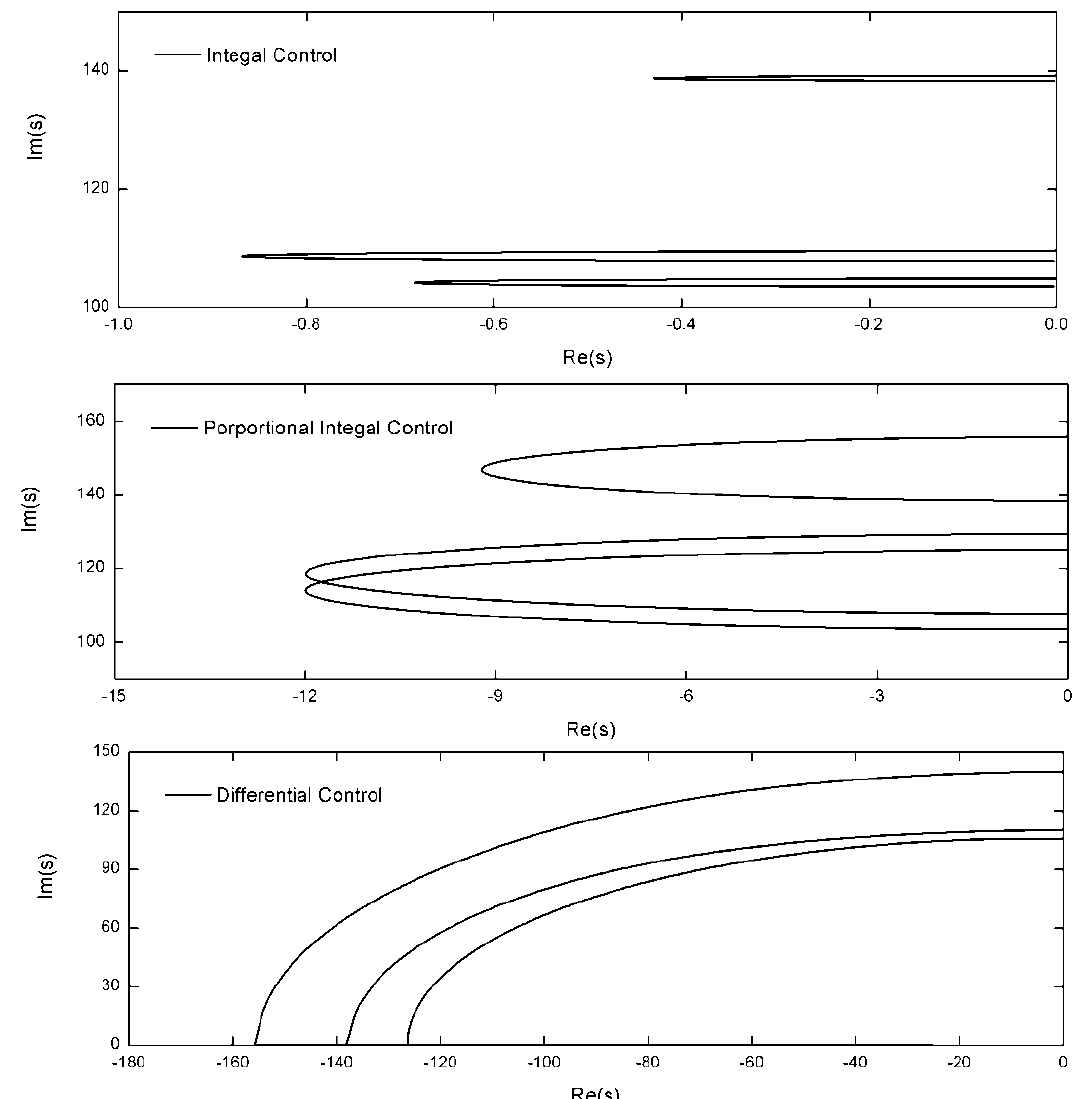
Figure 3. Root locus with three control strategies ( EA = 4,000 N